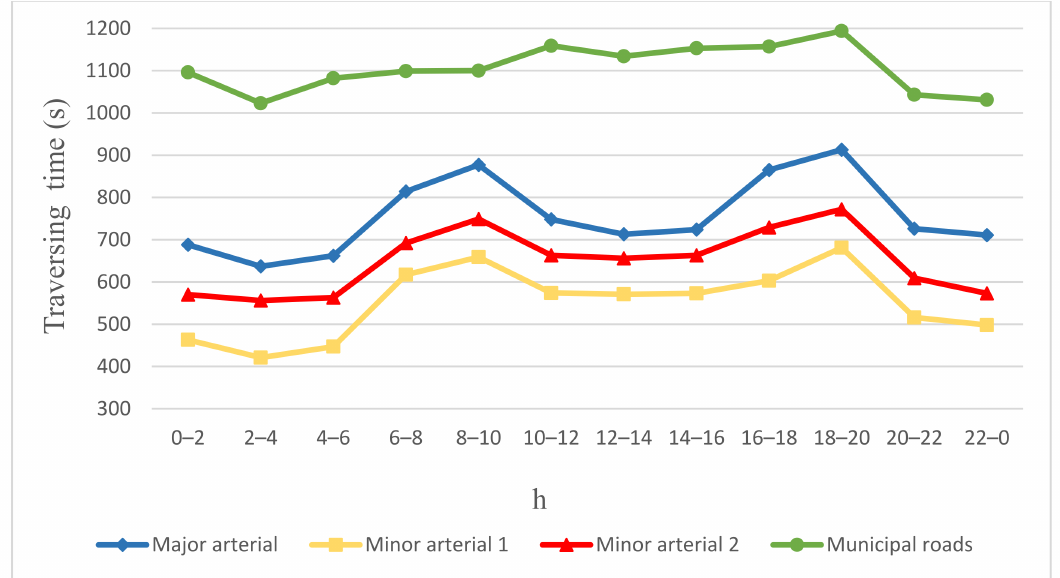
Figure 6. Traversing times of PEVs/SAEVs after rideshare companies support ridesharing